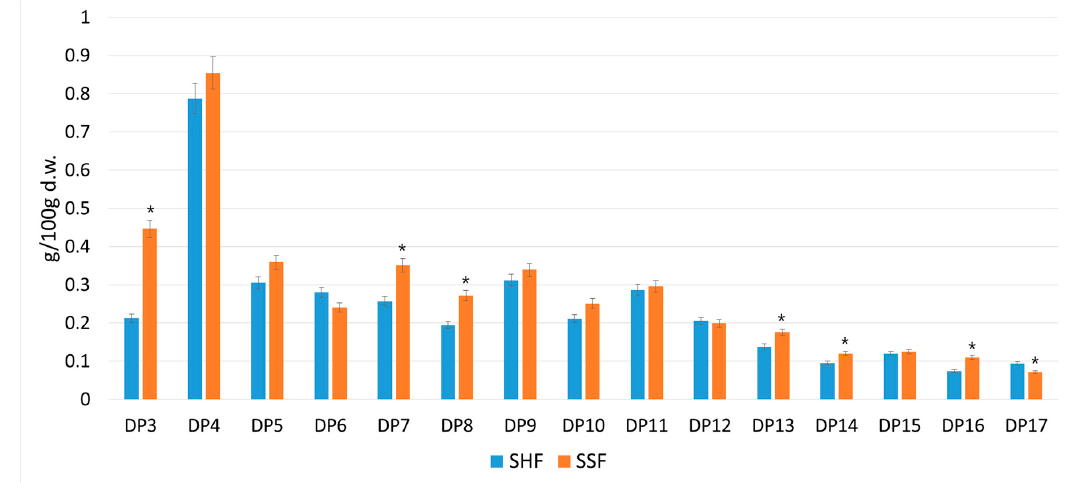
Figure 3. Yield of oligosaccharides with different degrees of polymerization DP3 ‒ DP17 obtained in the process of separate enzymatic hydrolysis and yeast cultivation (SHF), and simultaneous enzymatic hydrolysis and biomass cultivation (SSF). The data represent means from three replicates in one experiment. Error bars denote SD. * Results significantly different from control, ANOVA ( p < 0.05).